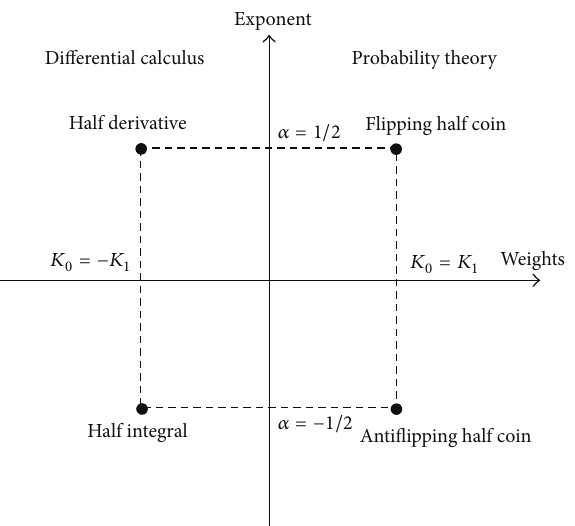
Figure 1: Conceptual diagram of the generalization of the worlds of probability and differential calculus.